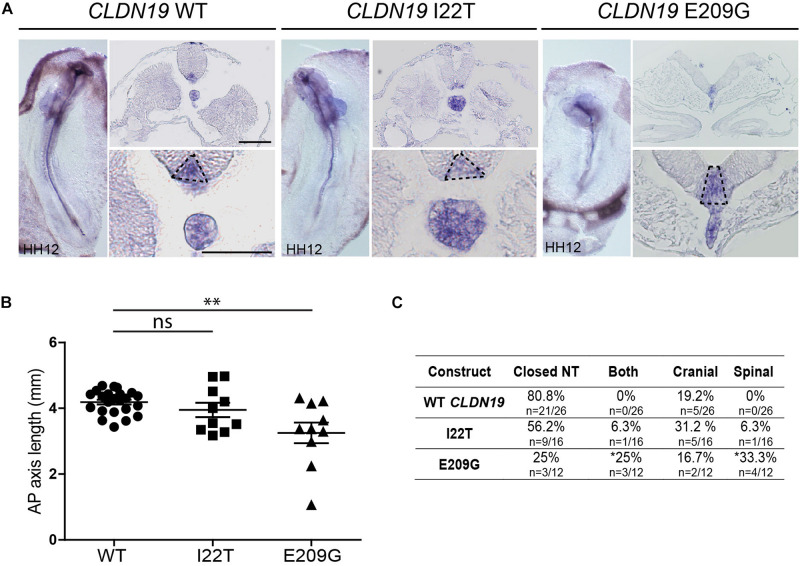
Embryos overexpressing CLDN19 E209G exhibit open NTDs due to convergent extension defects. (A) Left, whole mount in situ hybridization for Shh of embryos electroporated with wild-type (WT) CLDN19, CLDN19 I22T and CLDN19 E209G. Right, transverse sections through whole embryos. Dashed line in higher magnification view marks Shh expression domain in floor plate. Scale bar, 50 μm. (B) Graph shows anterior–posterior (AP) length of embryos electroporated with wild-type CLDN19, CLDN19 I22T and CLDN19 E209G at the neural tube stage (mean ± s.e.m., *p < 0.05, **p < 0.005, Mann–Whitney U-test). (C) Table showing the distribution of complete, cranial and caudal open NTDs observed in embryos overexpressing wild-type CLDN19, CLDN19 I22T or CLDN19 E209G (*p < 0.05, Chi-square test).